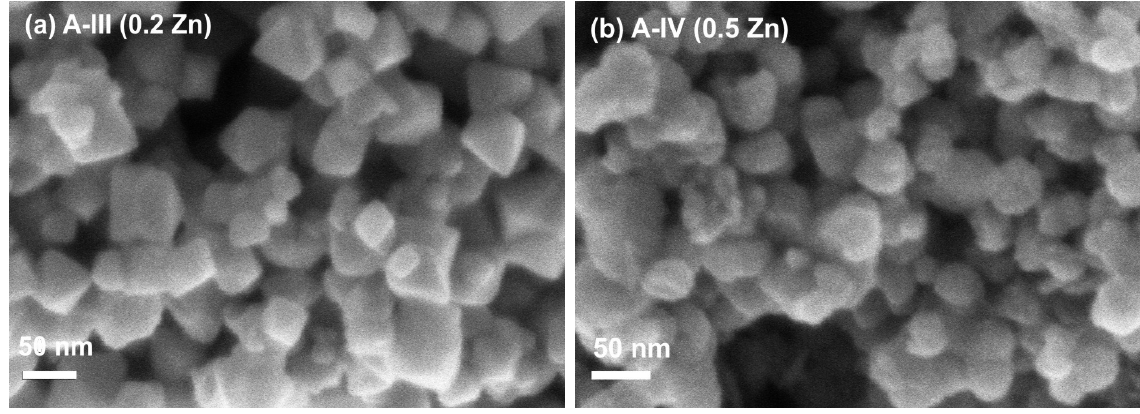
Fe O ) ( b 0.5 2.5 4